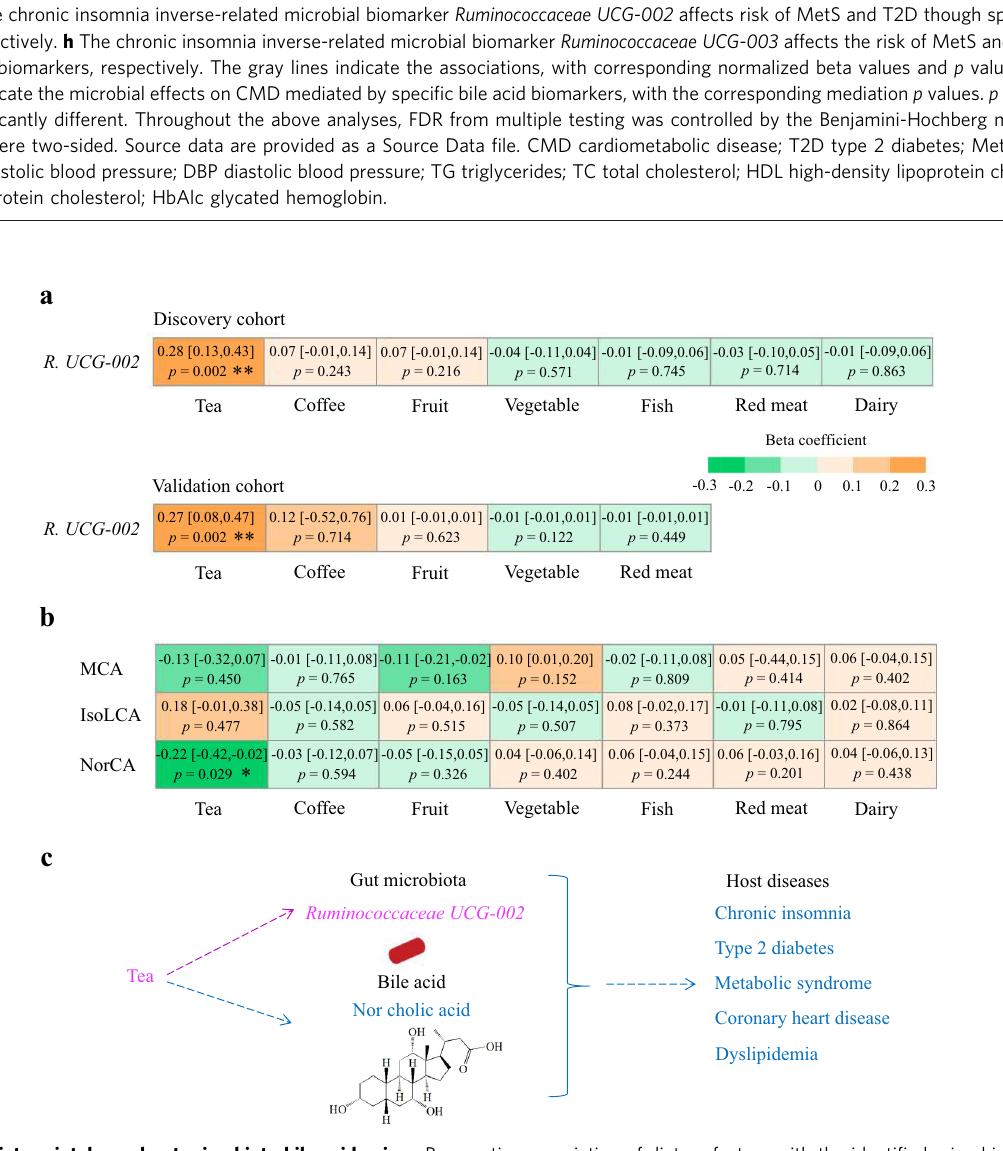
Fig. 4 Habitual dietary intake and gut microbiota-bile acid axis. a Prospective association of dietary factors with the identi fi ed microbial biomarker Ruminococcaceae UCG-002 in the discovery and validation cohorts. The results of Ruminococcaceae UCG-003 are reported in the Supplementary Fig. 7. Values presented are beta coef fi cients (95% con fi dence intervals) with corresponding p -values. b Prospective association of dietary factors with the identi fi ed bile acid biomarkers linking chronic insomnia and cardiometabolic diseases (CMD) in the GNHS. Multivariable linear regression was used to examine the prospective association of dietary factors with microbial and bile acid biomarkers, adjusted for the potential confounders. p value < 0.05 is considered signi fi cantly different. Value presented are beta coef fi cients (95% con fi dence intervals) with corresponding p -values. c Diagram of the link between habitual tea consumption, the gut microbiota-bile acid axis, and CMD. Habitual tea consumption was associated with higher abundance of Ruminococcaceae UCG-002 and lower abundance of the Nor cholic acid (NorCA). Value with asterisk is signi fi cantly different. (* p < 0.05, ** p < 0.01, *** p < 0.001). Throughout the above analyses, FDR was controlled by the Benjamini-Hochberg method. All statistical tests were two-sided. Source data are provided as a Source Data fi